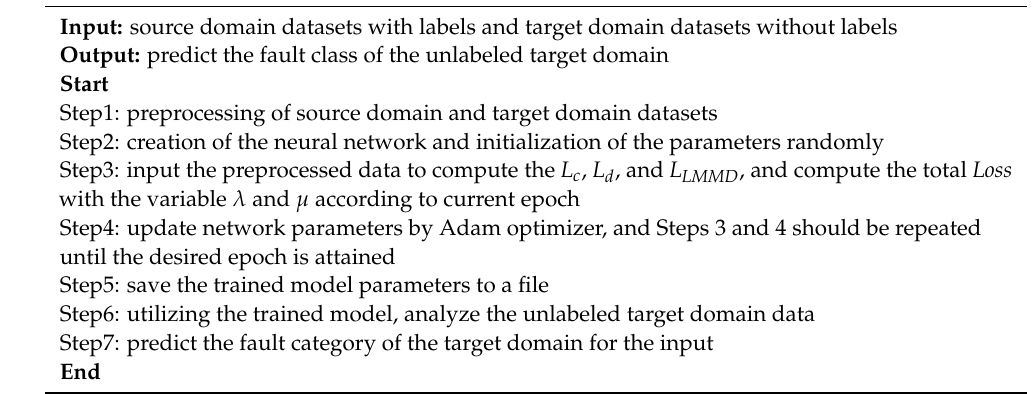
Algorithm 1 . DSTLN Training